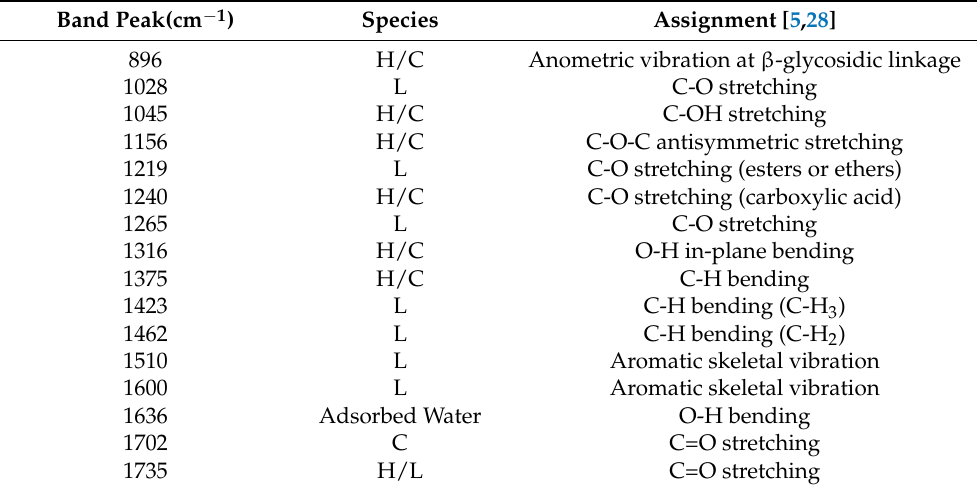
Figure 2. FTIR spectra of BIO01, BIO02, BIO03, and BIO04, where H, C, L and W stand for hemicellulose, cellulose, lignin, and water, respectively. Table 2. FTIR assignment in the region 800–2000 cm − 1 Table 2. FTIR assignment in the region 800–2000 cm −1 .